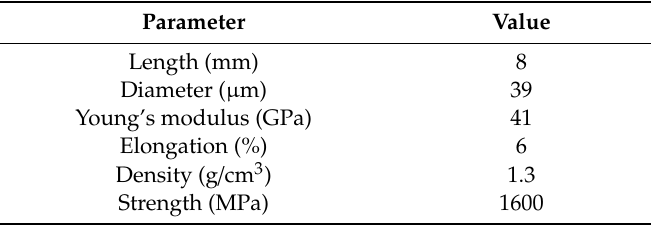
Table 2. Properties of poly vinyl alcohol (PVA)